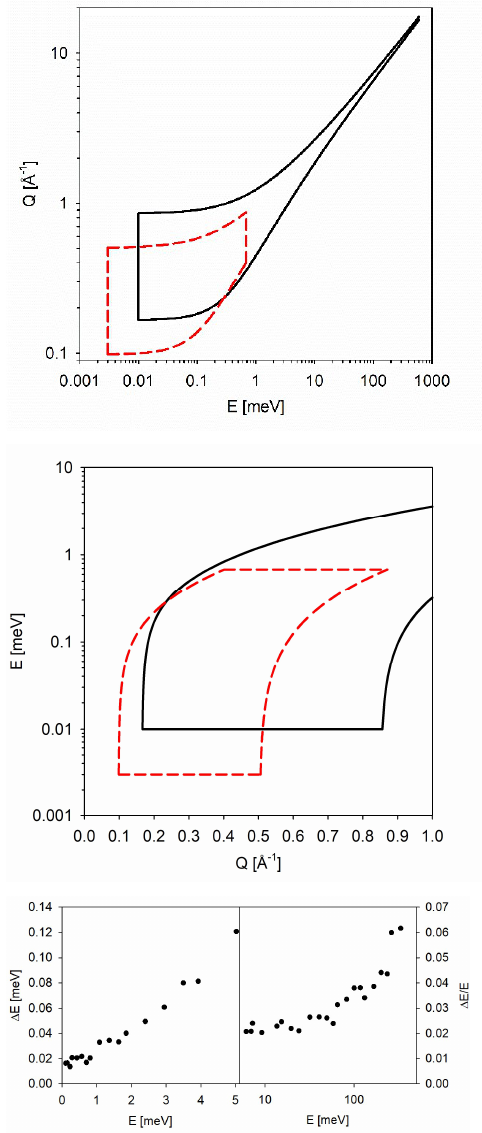
Fig. 1 . Top panel: solid lines: the (E,Q) space coverage provided by the BWAVES spectrometer using the default  f = 14.50 Å in the standard operation mode. Also presented (dashed lines) is an example of the BWAVES “booster” mode with  f = 24.50 Å chosen for illustration. Middle panel: zoomed-in and truncated data from the top panel replotted as a function of Q. Bottom panel: the simulated energy resolution of BWAVES. Absolute energy resolution,  E (full width at half-maximum), up to 5 meV (left) and relative energy resolution,  E/E above 5 meV (right).